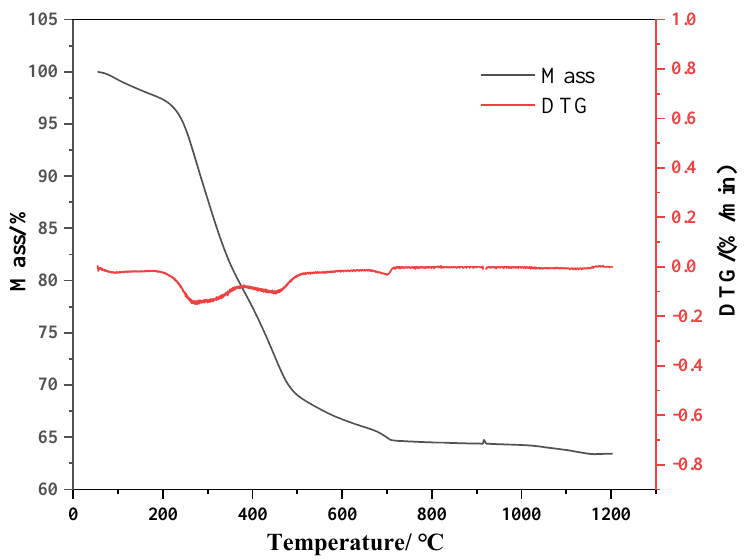
Figure 2. TGA and DTG curves during sludge pyrolysis. The change in sludge pyrolysis PM weight with the pyrolysis temperature is shown in Figure 3. It was obvious that the PM mass increased with the temperature. When the temperature was higher than 500 ◦ C, the increase trend slowed down. Combined with the DTG curve analysis, the change process of the PM weight was mostly affected by the change trend of the pyrolysis gas phase